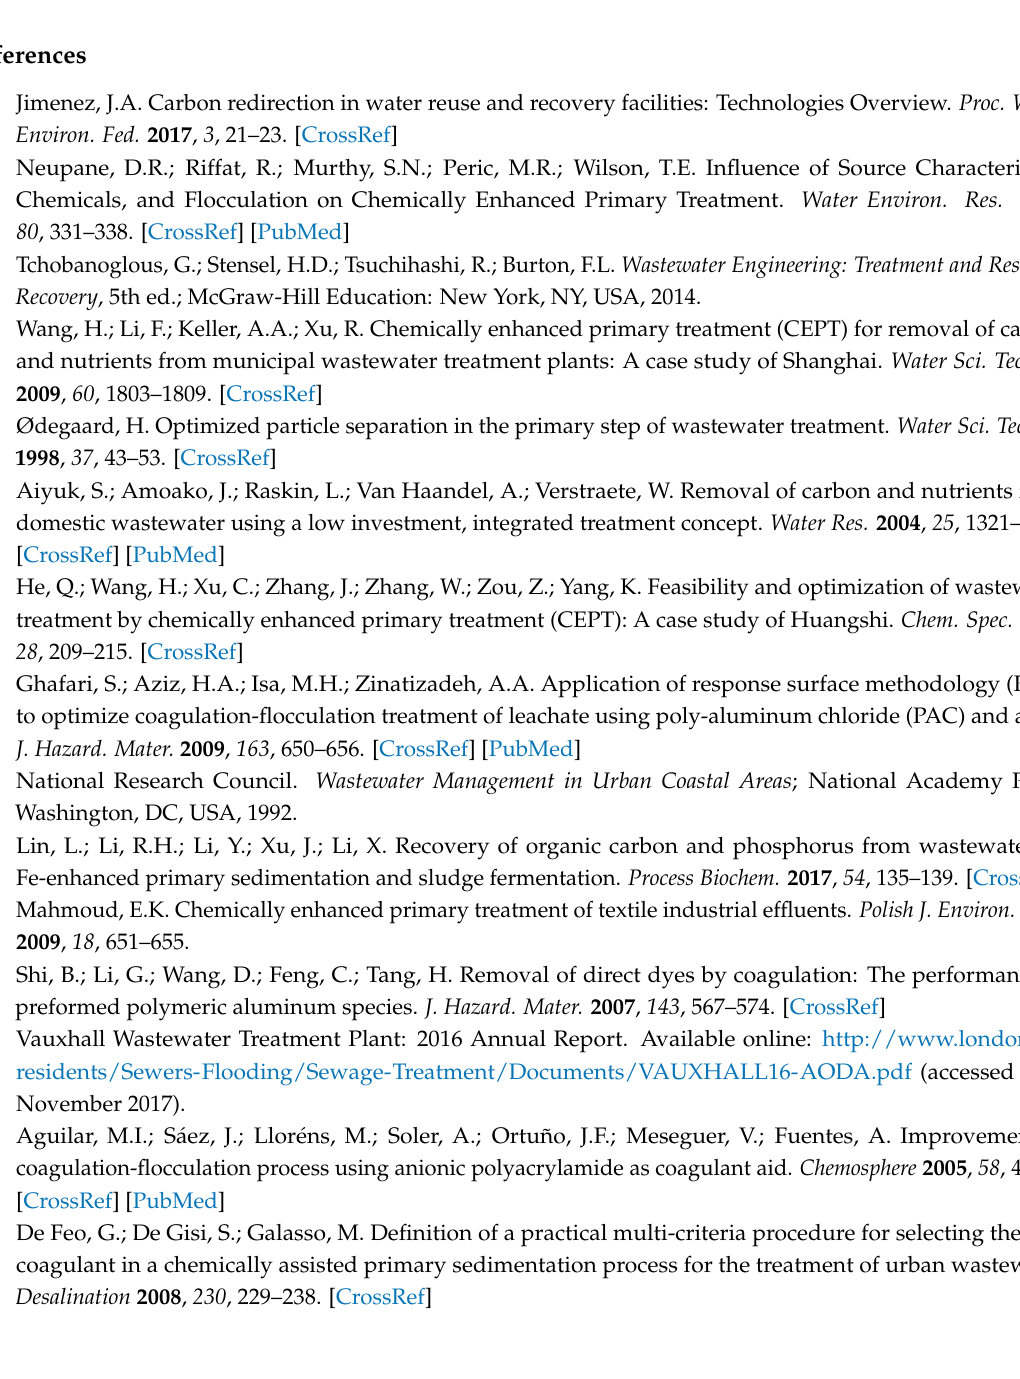
Figure S1: Seasonal changes in influent flow rate and temperature of Vauxhall